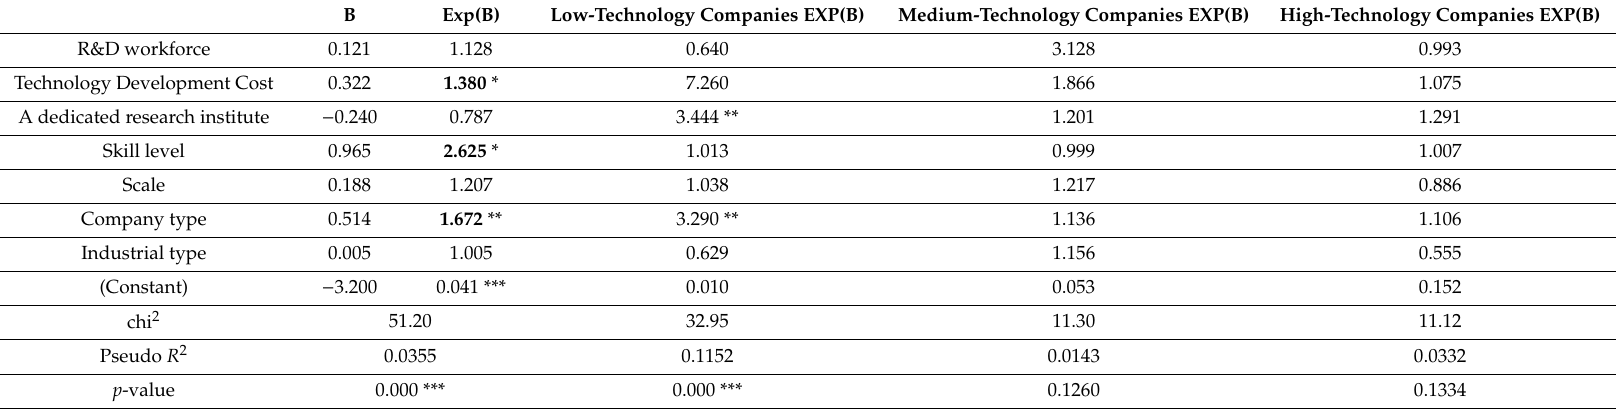
Table 4. Logistic analysis result of technical competitiveness of technology development performance.